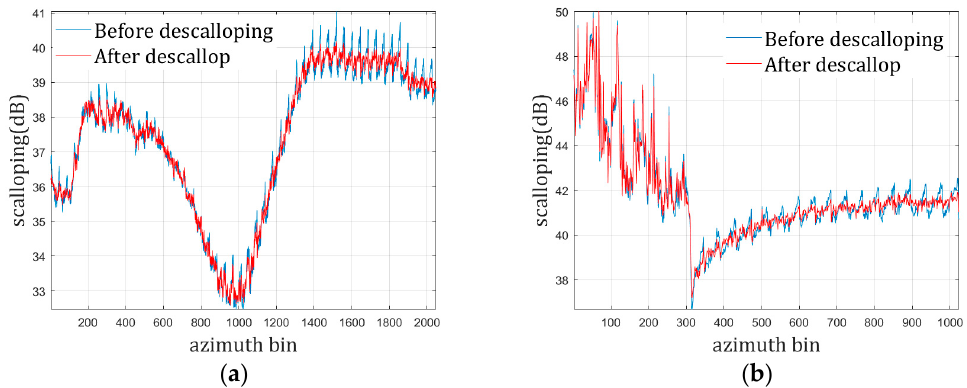
Figure 18. Scalloping profiles before and after descalloping: ( a ) scalloping profiles of Figure 16a,b; ( b ) scalloping profiles of Figure 17a,b.